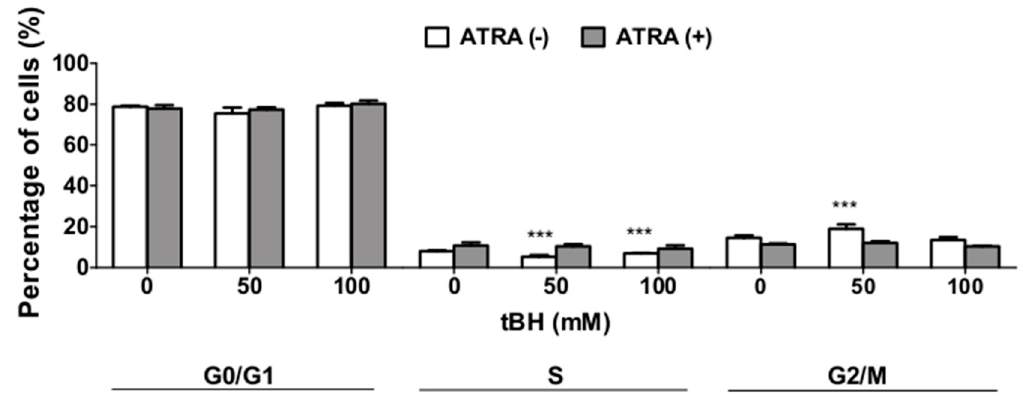
Figure 5. Cell cycle of ATRA-treated and control ARPE-19 cells exposed to tert -butyl hydroperoxide (tBH) for 24 h at 37 °C as assessed by flow cytometry analysis of propidium iodide (PI) staining. Results are presented as mean ± SEM, n = 8, *** p < 0.001. Representative FACS analysis of cell cycle profiles are presented.